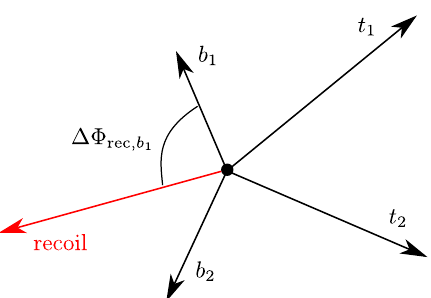
Figure 17. Sketch of the azimuthal angular correlation (cid:1) (cid:30) t (cid:22) tb (cid:22) b system and its recoil. See